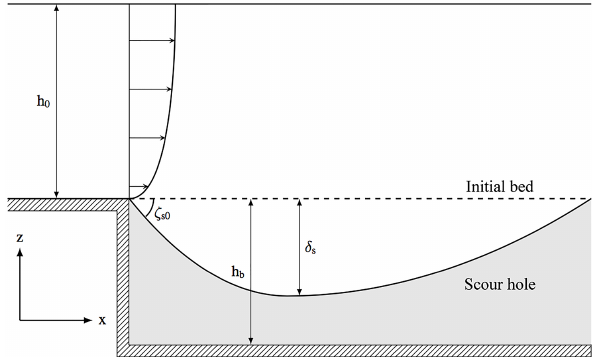
Figure 5. Sketch of the scour downstream of an